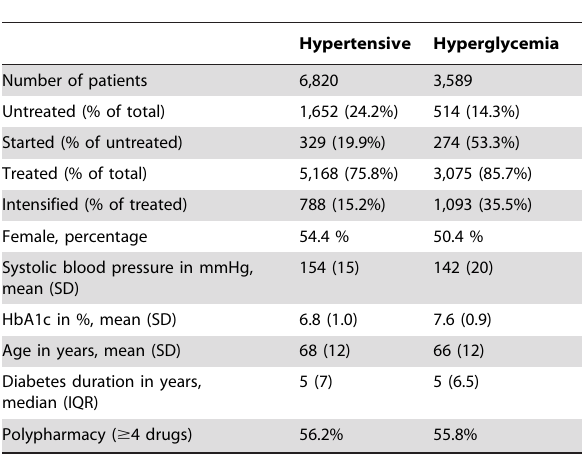
Table 2. Characteristics of the hypertensive and the hyperglycemia